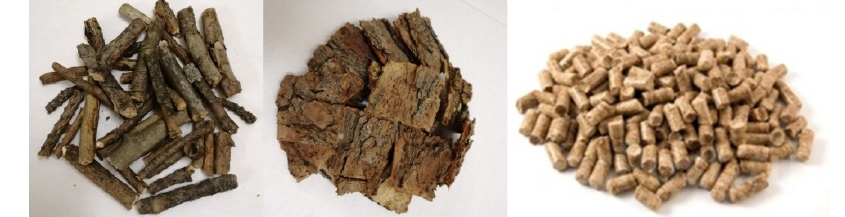
Figure 3. Firebrand samples.